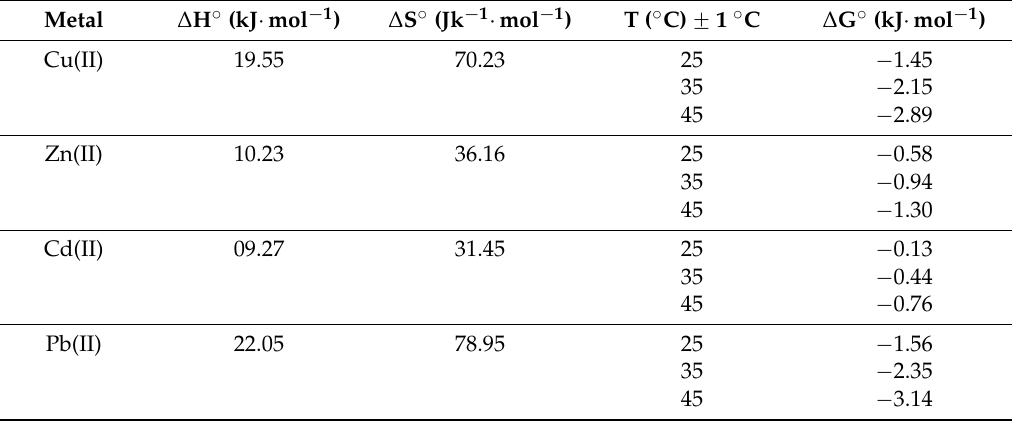
Table 4. Adsorption models used in this work and their parameters (shaking time 60 min, pH = 6, V = 10 mL, m = 10 mg of SiNTh-Py at optimum concentration: 140 mg/L in each case).